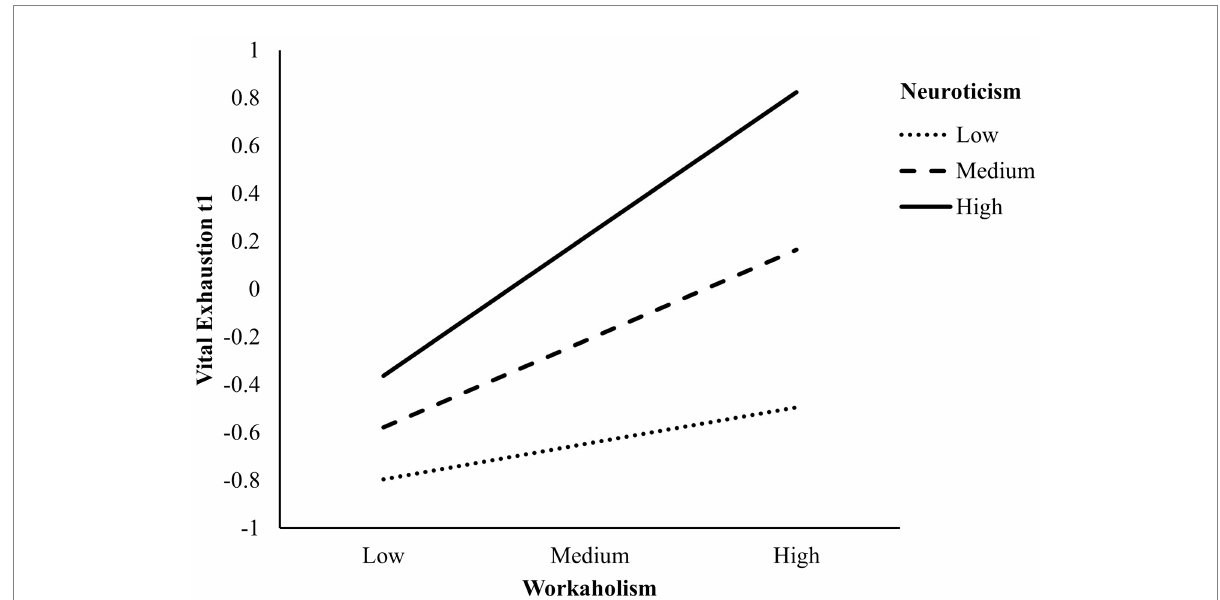
FIGURE 1 Interaction between workaholism x neuroticism on vital exhaustion at t1, controlling for sex ( N = 39).